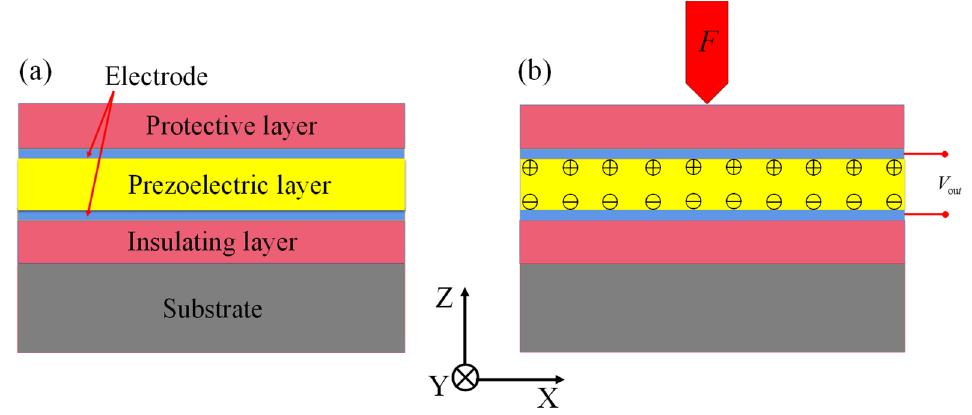
Figure 1. Working principle of piezoelectric film sensor: ( a ) normal state; ( b ) applied external force F .